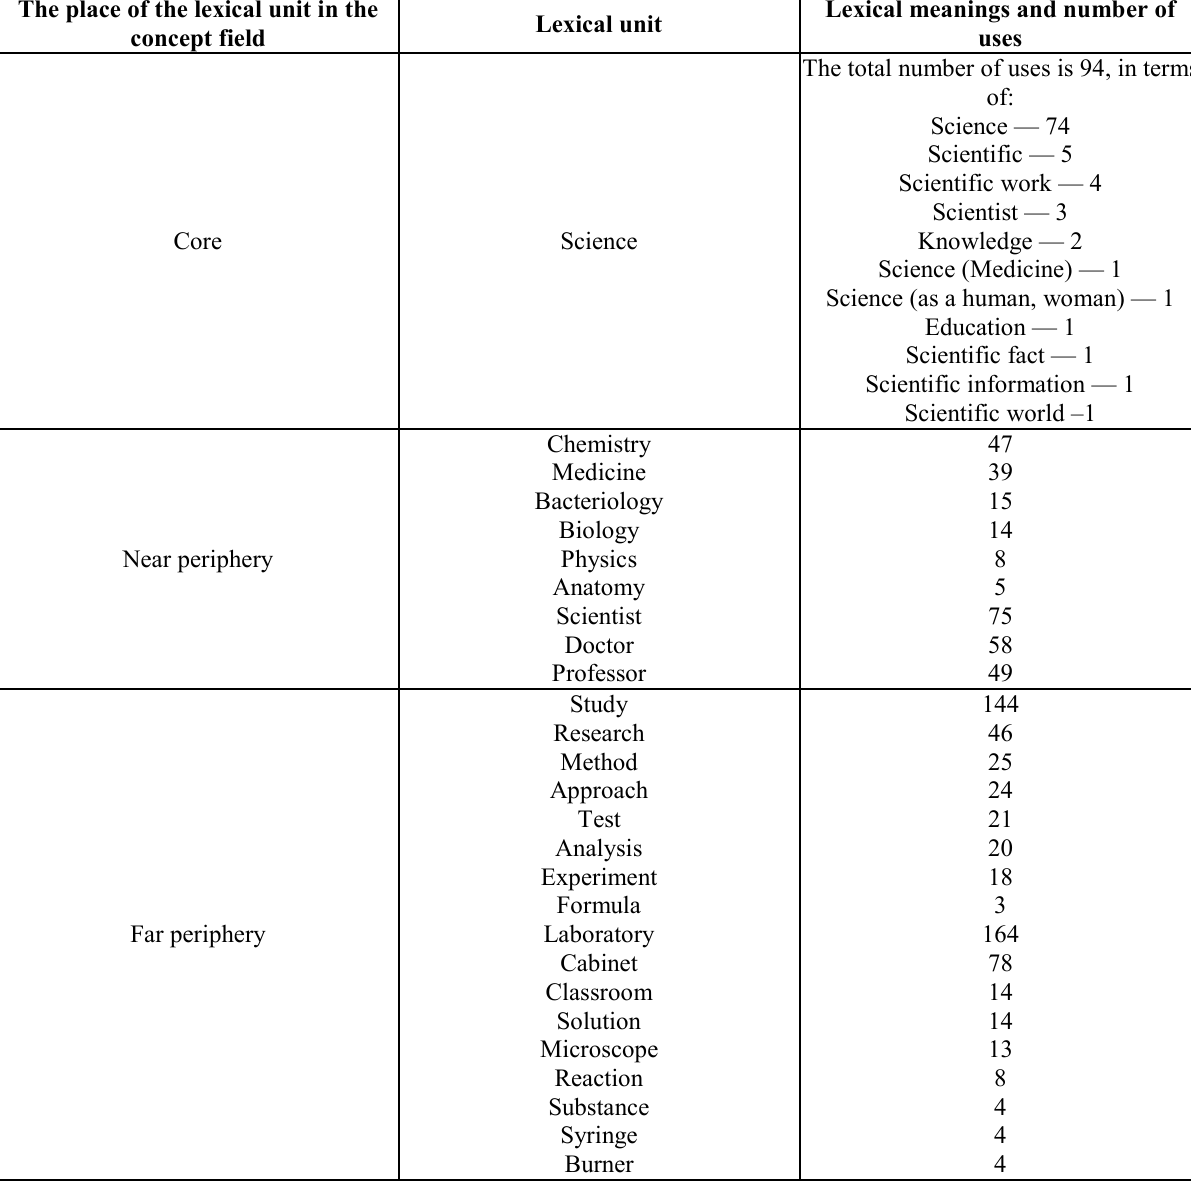
Table 1 — Semantic and quantitative correlation of the lexis included in the field of the concept "Science" in S. Lewis's novel "Arrowsmith" The place of the lexical unit in